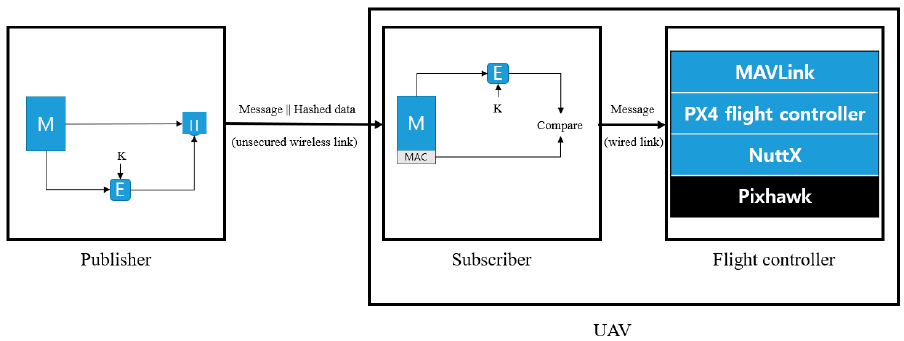
Figure 14. Security framework for ROS.